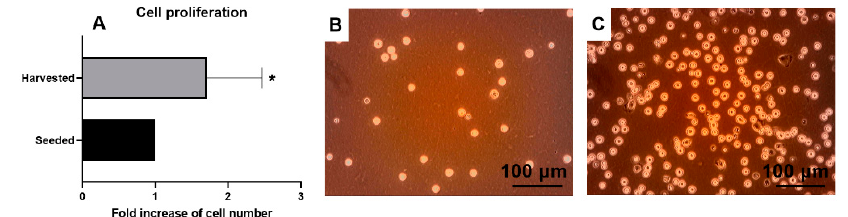
Figure 3. Proliferation rate of the cultured CD45 − cells. Cell number was increased almost two-fold during the culture ( A ). Number of cells after seeding ( B ) and at the end of culture ( C ) observed under a Zeiss Primovert phase-contrast microscope (magnification at 100×; scale bar = 100 μ m). The data from eight experiments are expressed as the mean ± SD; *—difference is statistically significant at p < 0.05.